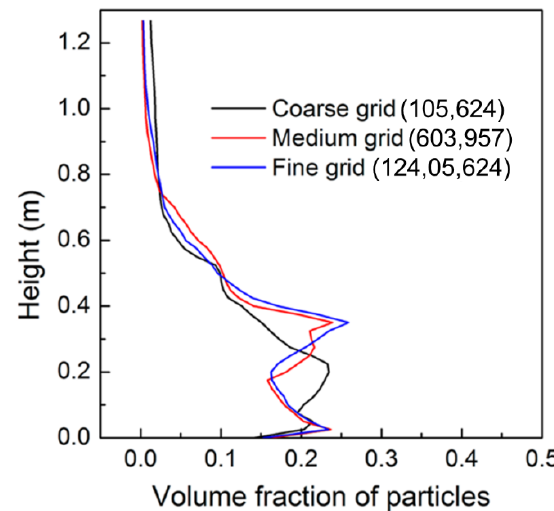
7 of 16 Figure 1. Schematic of fluidized bed gasifier. Table 3. Industrial analysis and elemental analysis of biomass particles. Components